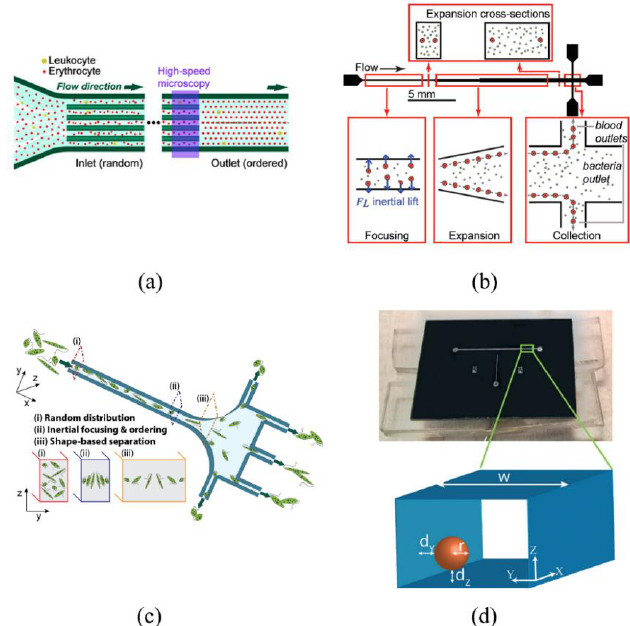
Figure 6. Applications of straight-rectangular-channel inertial microfluidics. ( a ) Counting and differentiation of red blood cells and leukocytes in blood. Ref. [23]. Copyright (2009), with permission from Royal Society of Chemistry; ( b ) Separating pathogenic bacteria cells from diluted blood. Ref. [57]. Copyright (2010), with permission from Wiley Periodicals, Inc.; ( c ) Inertial focusing and ordering of Euglena gracilis . Ref. [58]. Copyright (2017), with permission from Springer Nature; ( d ) Inertial manipulation of bubbles in rectangular microfluidics channels. Ref. [60]. Copyright (2018), with permission from Royal Society of